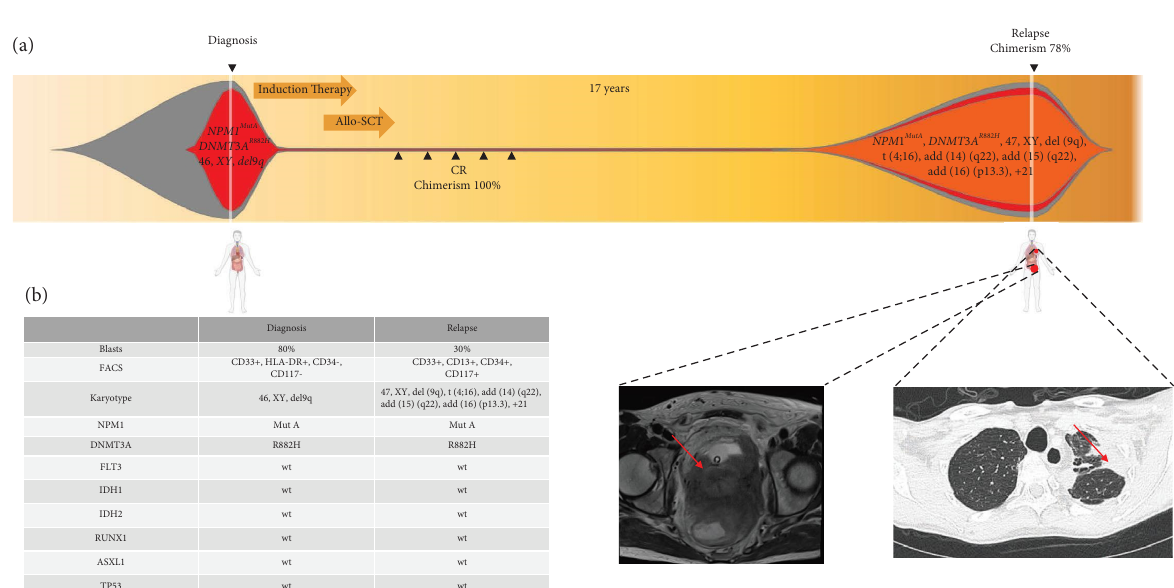
Figure 1: (a) Schematic presentation of treatment and genetic evolution in a patient with NPM1 -mutated AML. Te patient had no evidence of extramedullary disease at diagnosis and presented with a chloroma in the lesser pelvis and pulmonary lesions at relapse, as shown in the MRI and CT scan, respectively. (b) AML characteristics of leukemia at diagnosis and